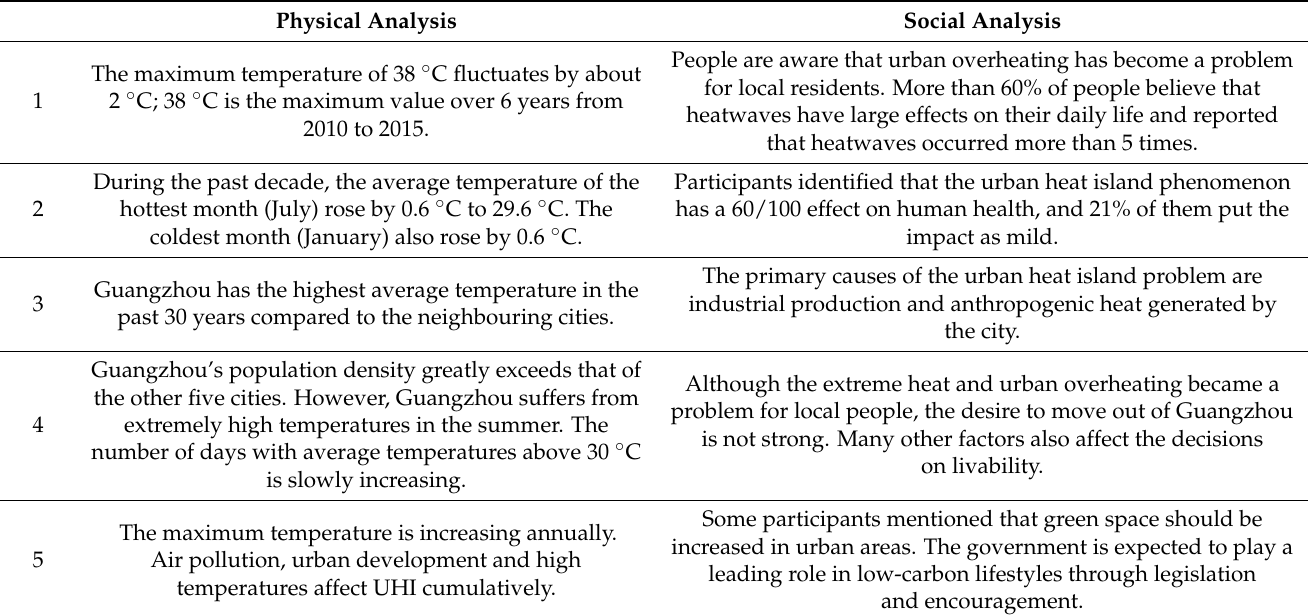
Table 3. Trend of physical and social survey